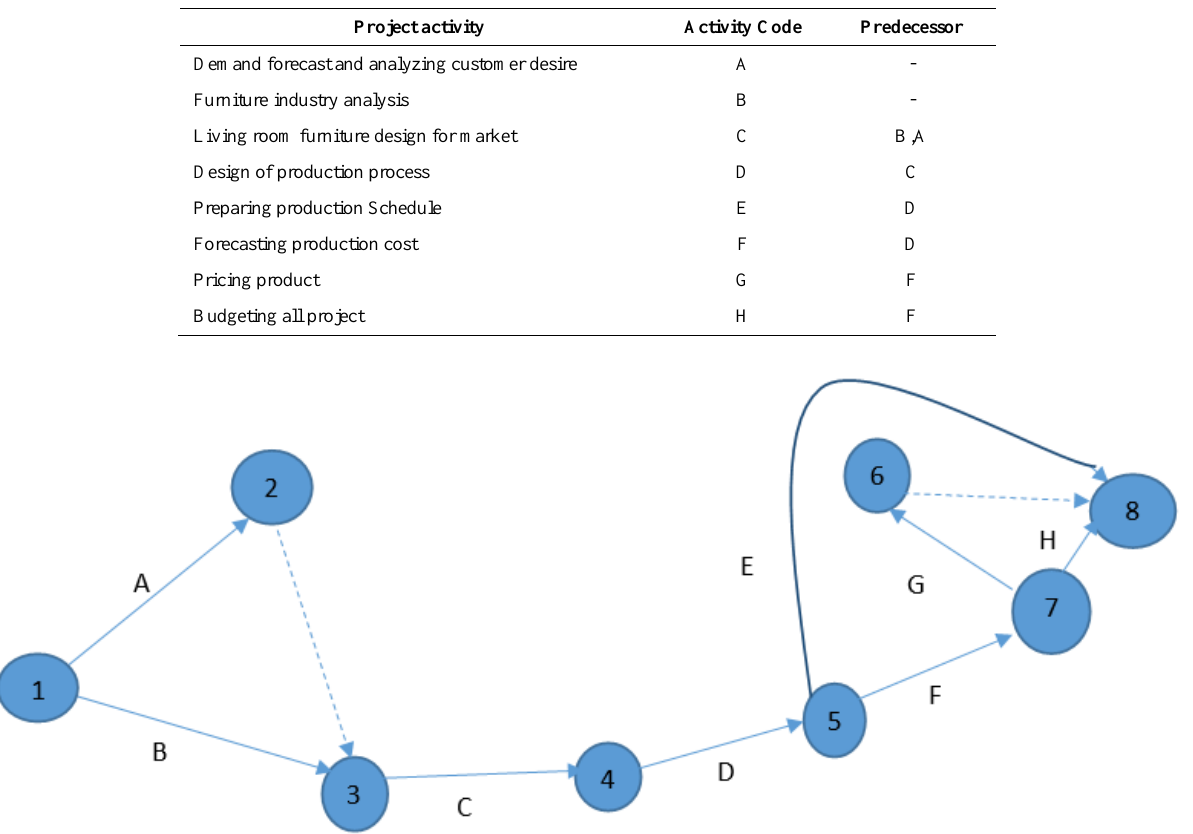
Figure 10. Project network of Living room furniture design and market entry project.